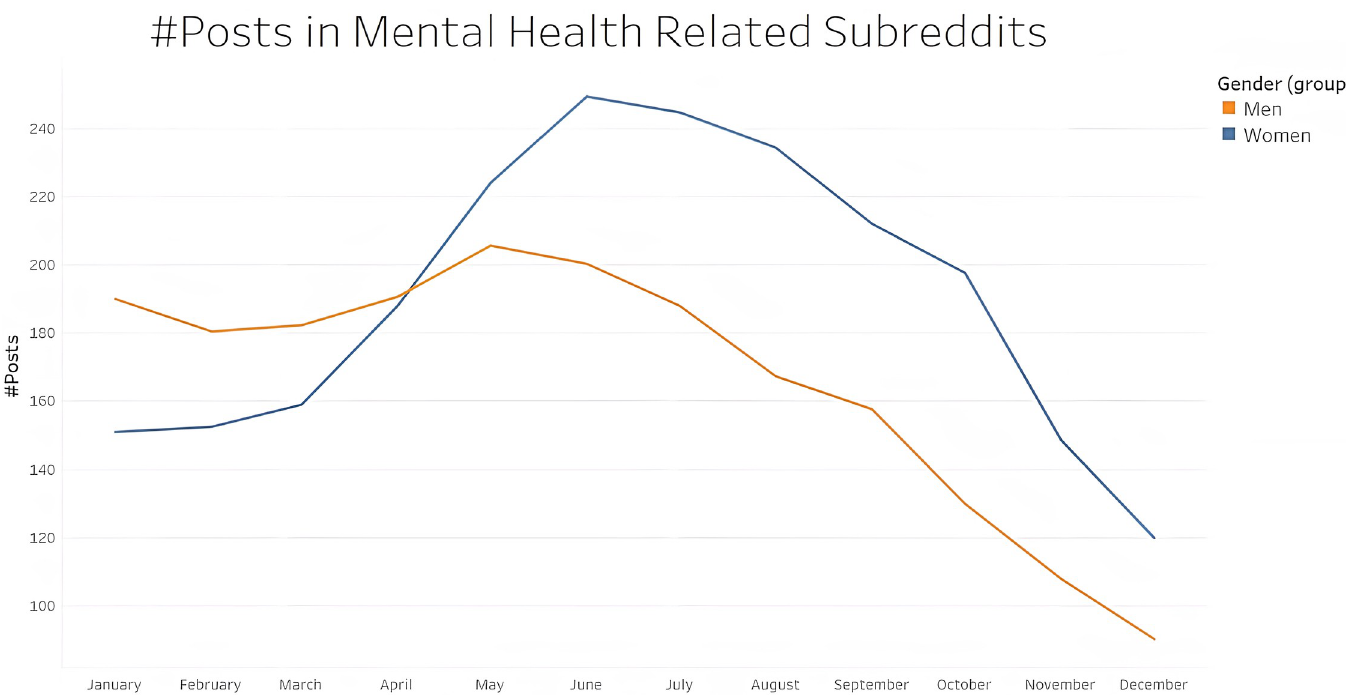
Fig 1. Change in number of mental-health related posts in 2020 based on gender. The orange line represents all unemployed women redditors and the blue represents all unemployed men redditors. Starting from March 2020, the number of mental health related subreddits increased noticeably for women.